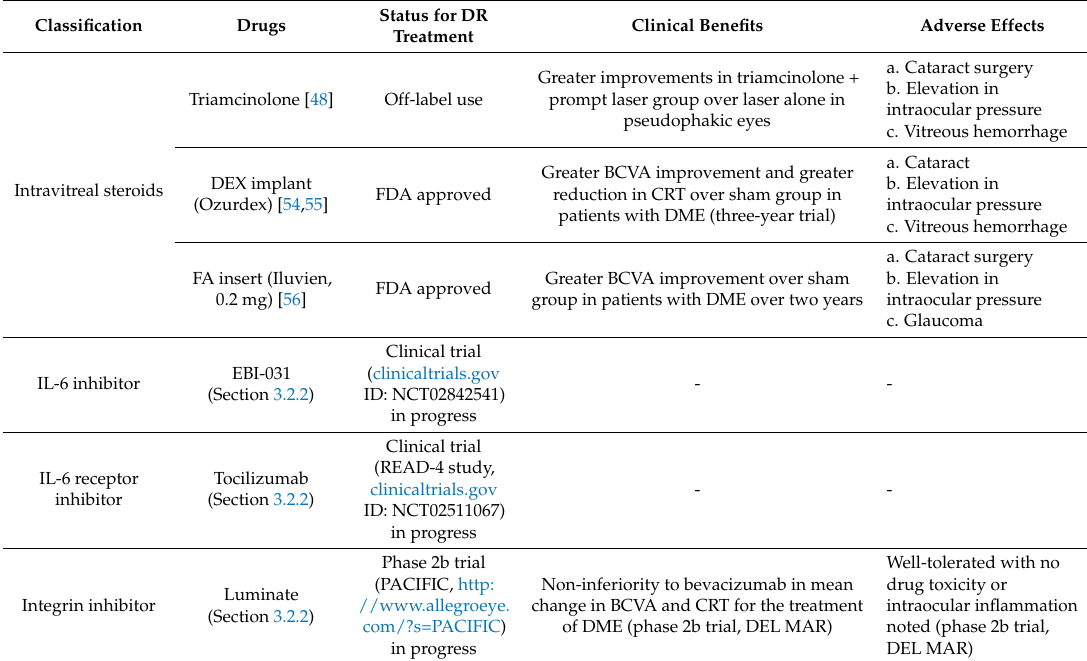
Table 2. Anti-inflammatory drugs for the treatment of